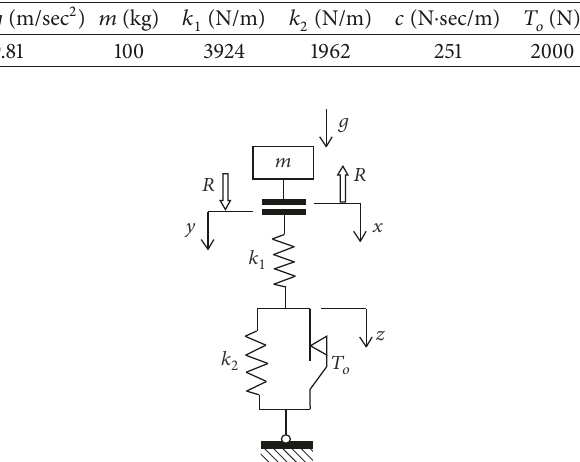
Table 1: Parameters of mechanical systems shown in Figures 1, 3, and 6.